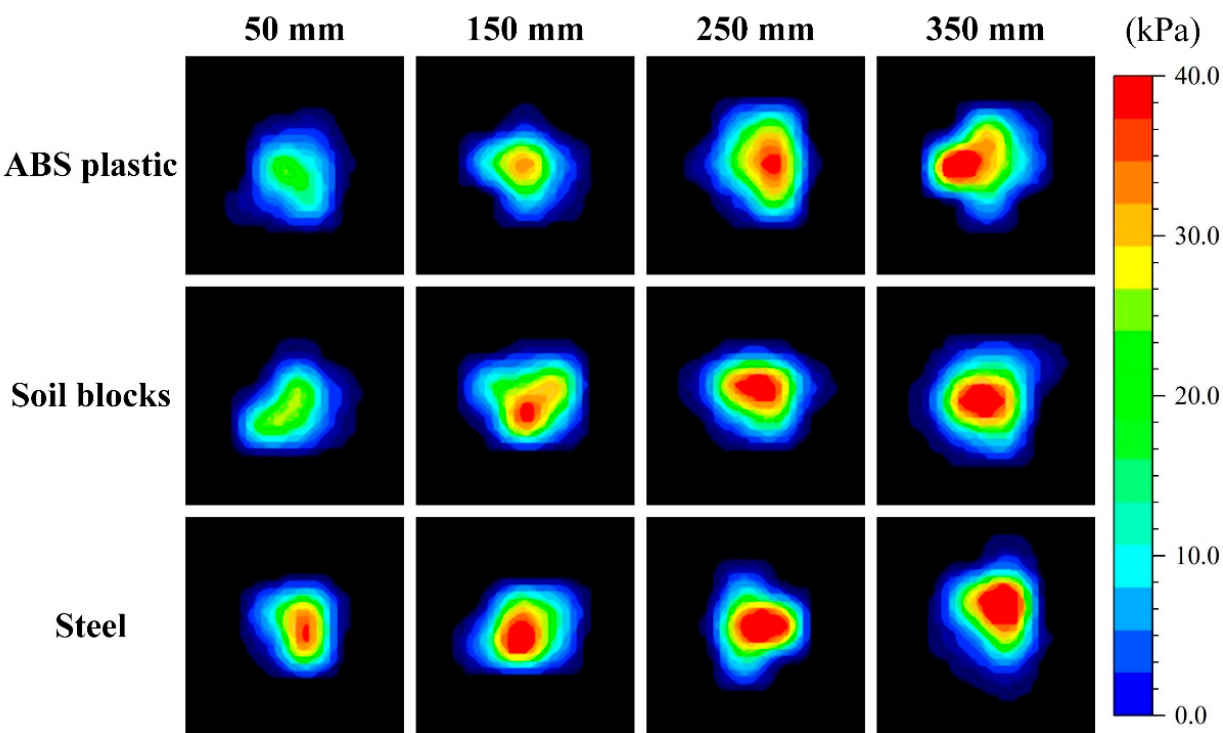
Figure 7. Pressure distribution contours at different drop heights for three collision materials.